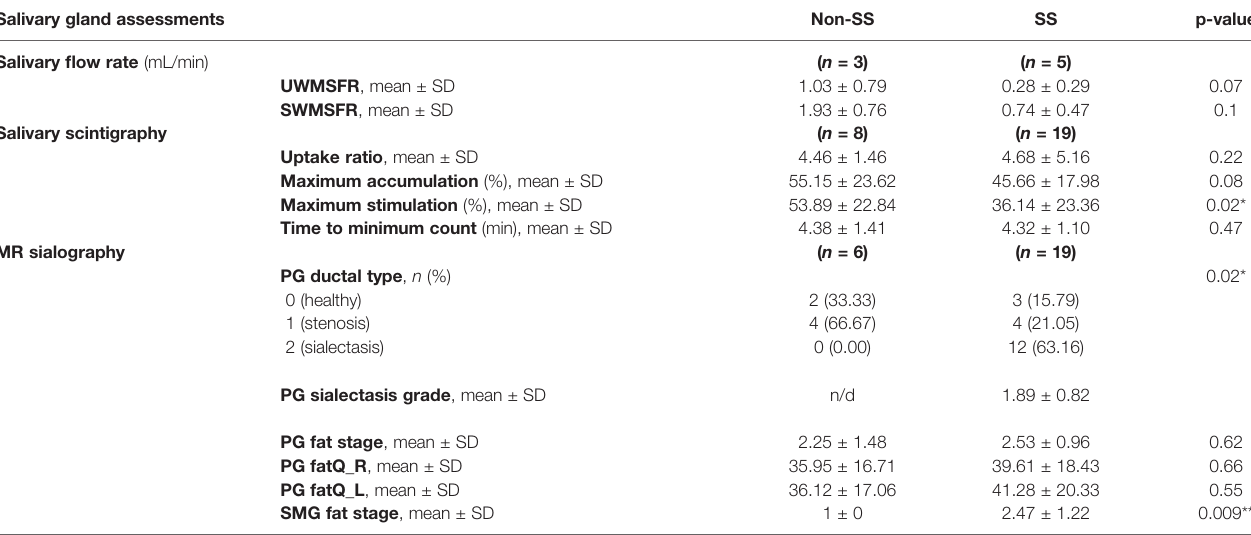
TABLE 2 | Clinical features of non-SS and SS